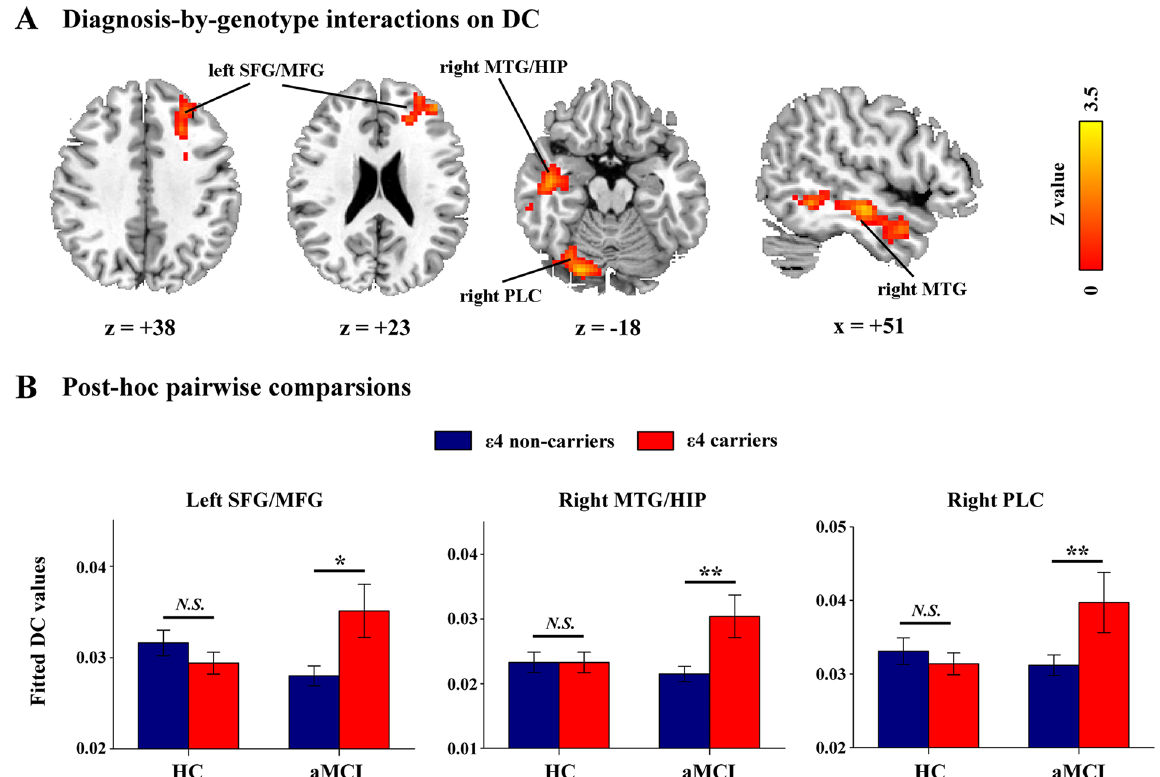
Figure 1. Diagnosis-by-genotype interactions on DC. ( A ) Two-way ANCOVA revealed significant diagnosis- by-genotype interactions on DC in the left superior/middle frontal gyrus (SFG/MFG), right middle temporal gyrus (MTG) extending to the hippocampus (HIP), and right posterior lobe of the cerebellum (PLC). The color bar indicates the statistical significance threshold ( Z -score). Multiple comparisons were performed by a combined | z | > 1.96 ( P < 0.05) and cluster size > 4,266 mm 3 , which corresponded to a corrected P < 0.05. ( B ) The bar graphs illustrate post-hoc pairwise comparisons in the regions showing significant diagnosis- by-genotype interactions. The differences between the ε 4 carriers and non-carriers were significant in the aMCI group but not in the HC group. The data were expressed as the mean (M) ± standard error (SE). DC, degree centrality; HC, healthy control; and aMCI, amnestic mild cognitive impairment. N.S. , Non-significant. * P < 0.05, ** P < 0.01.